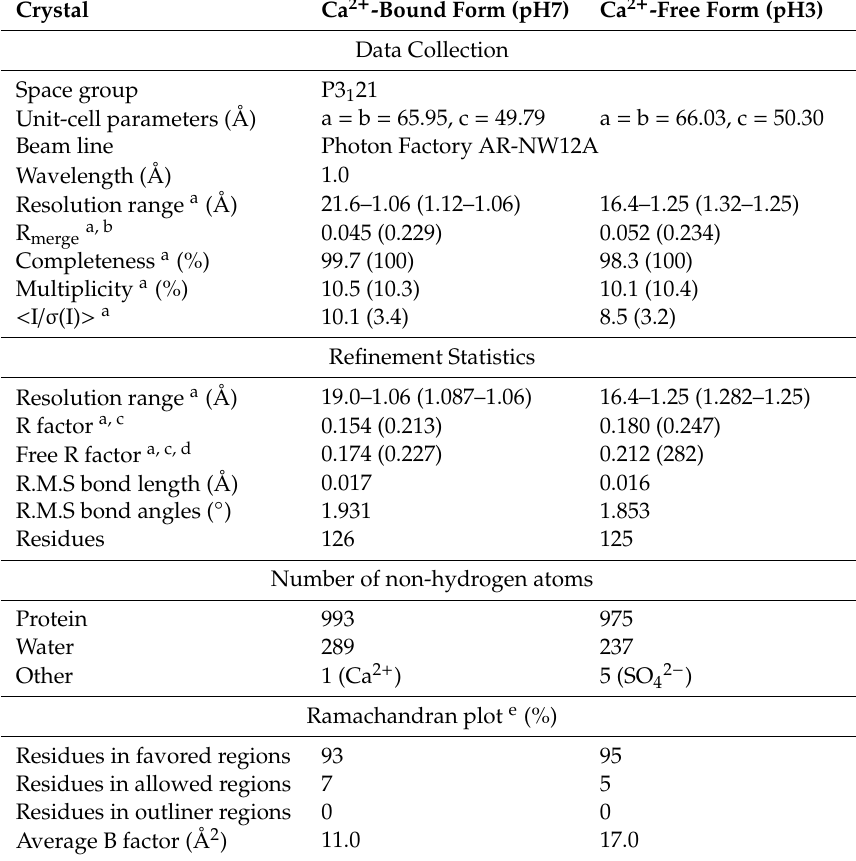
Table 1. Crystallographic data of X-ray structure of